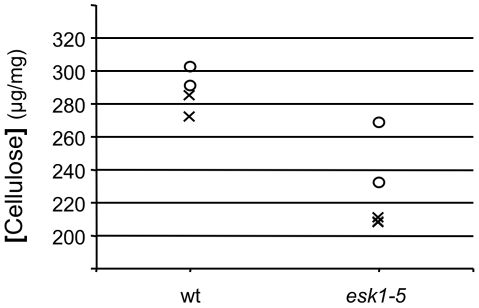
Crystalline cellulose content is reduced in esk1-5 hypocotyl.Cellulose contents expressed as % of hypocotyl dry weight. Data from 4 measurements are plotted. The decrease in esk1-5 cellulose content compared to wild type (wt) was significant using Mann and Whithney non parametric test (p-value<0.05).